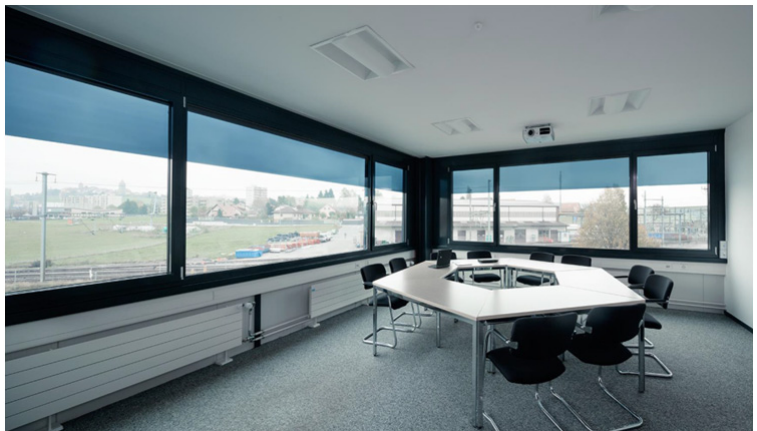
Fig. 7 Example of one of the new developments in EC glazing: in-pane zoning. This shows EC glass installed in a refurbished building in Switzerland with the top of each pane in a tinted state and the bottom in a clear state. © Vetrotech